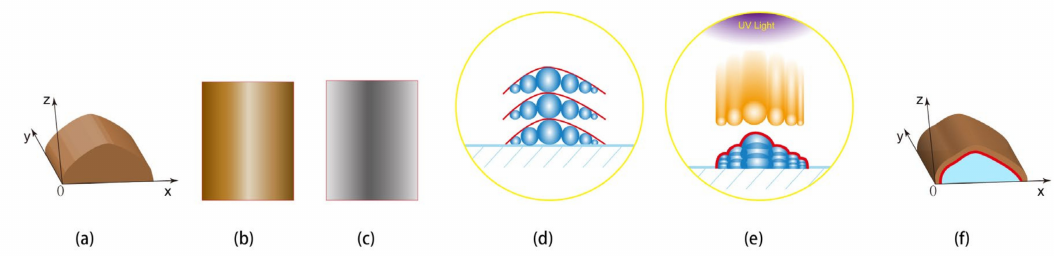
Figure 10. ( a ) A wood texture, ( b ) color image scanned, ( c ) grayscale image scanned, ( d ) white UV-curable ink overlap drove by grayscale image, ( e ) color image texture mapping printing on the white ink deposition model, and ( f ) a replicated printing wood